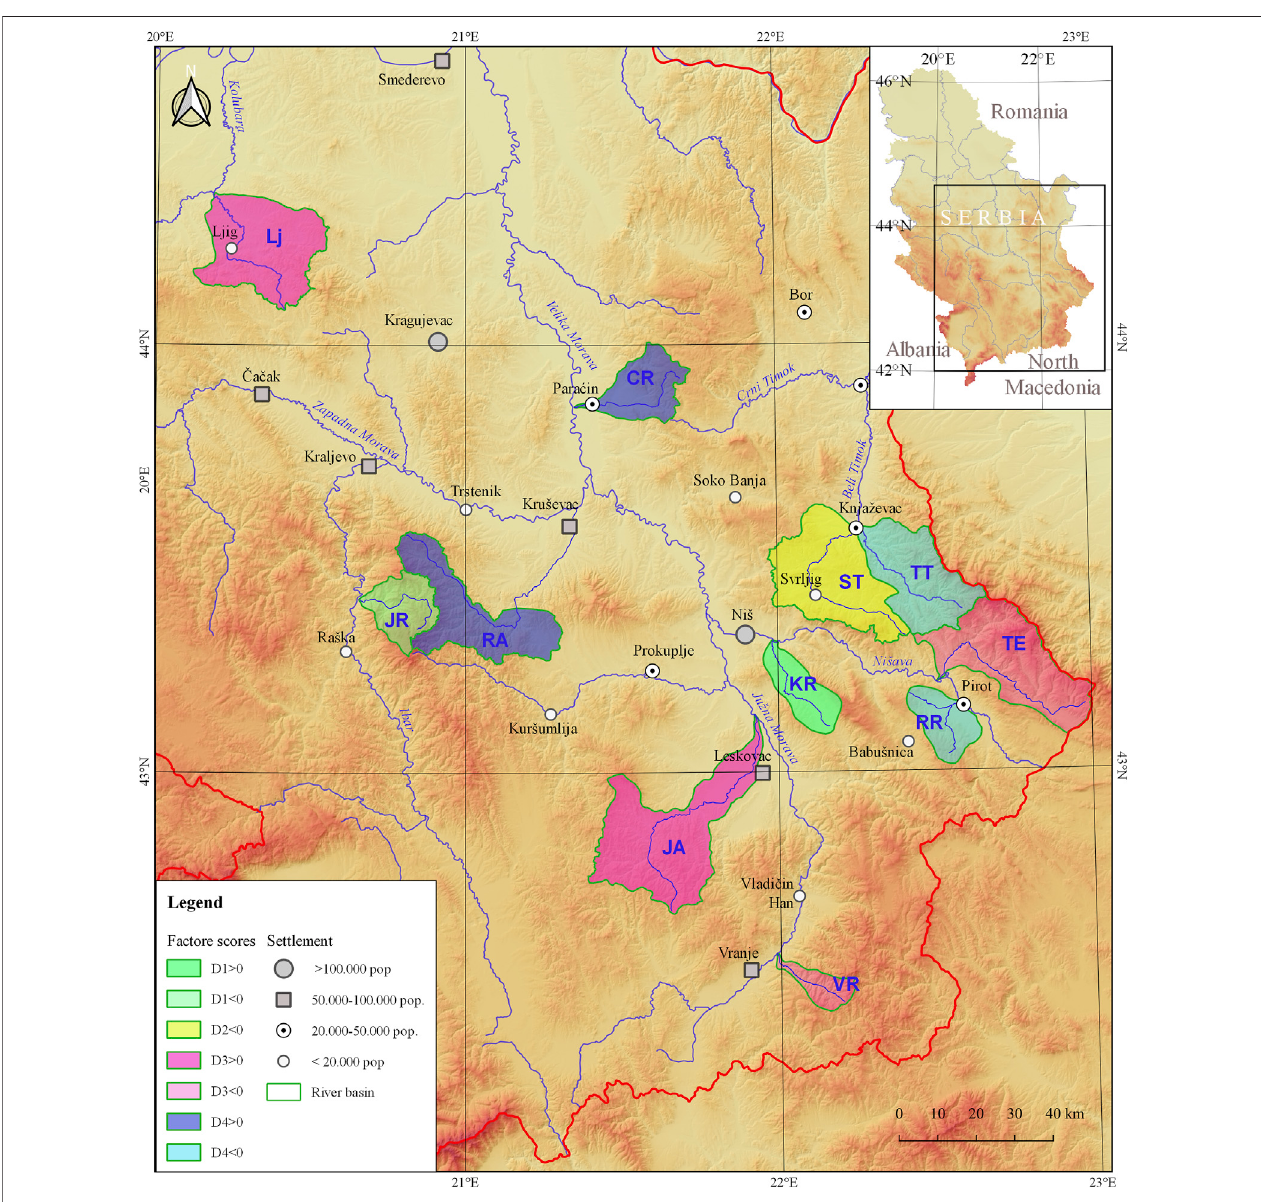
FIGURE 3 | Spatial distribution of watersheds according to factor scores for dominant variables of changes in soil erosion intensity.